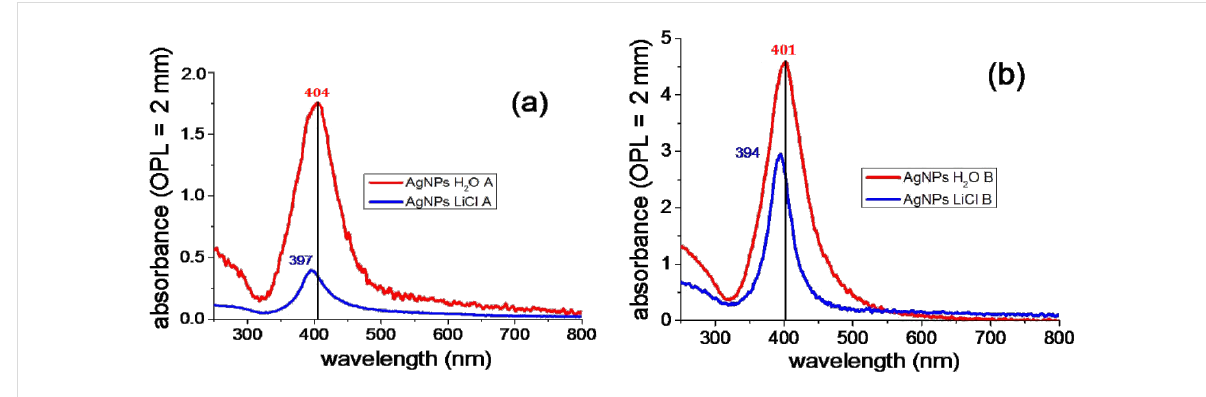
Figure 1: UV–vis absorption spectra of AgNPs in colloidal suspensions obtained with (a) ps and (b) ns laser ablation.